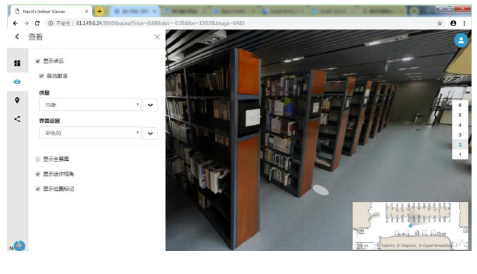
Figure 8. Adds POI to the bookshelf